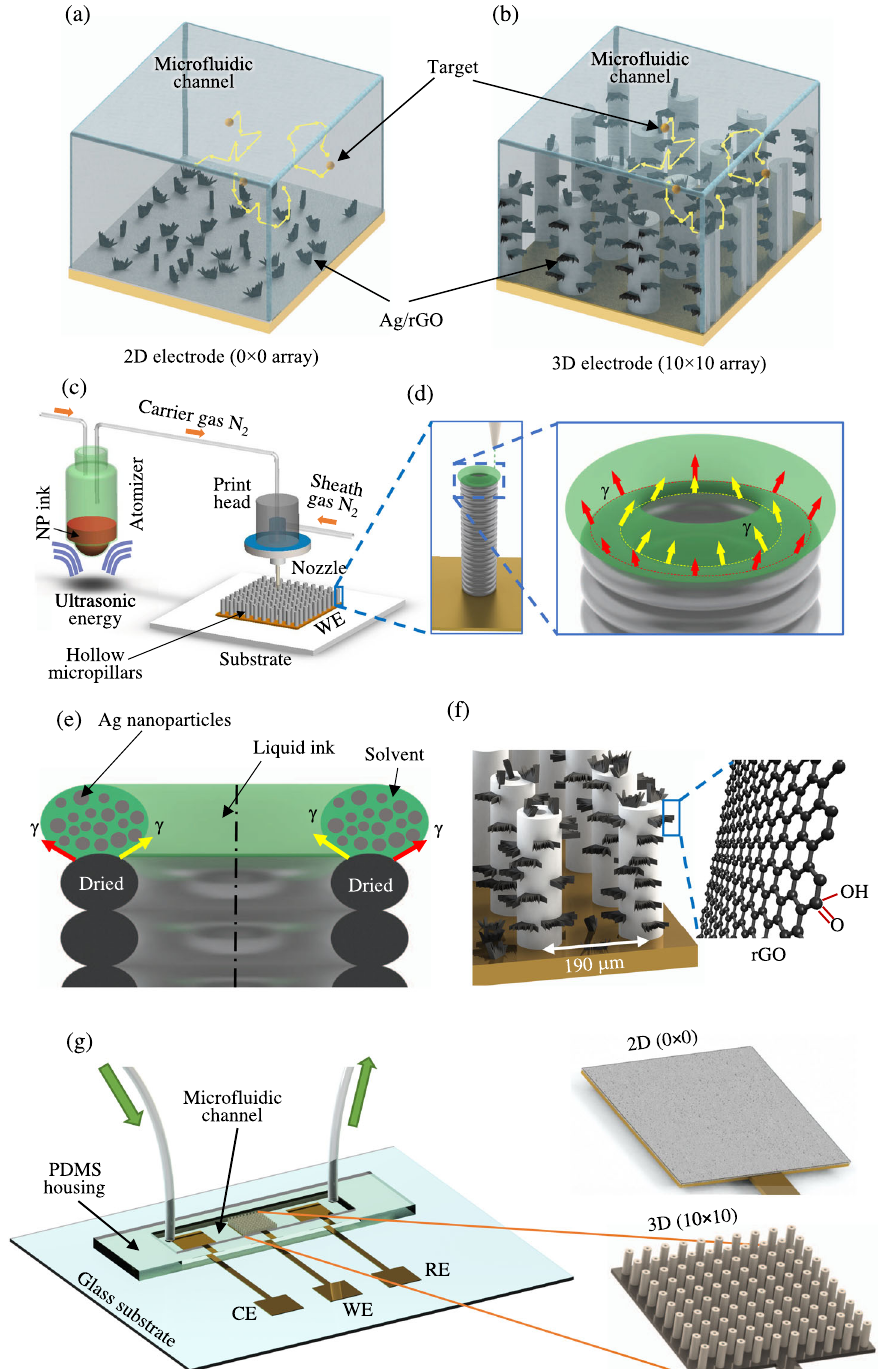
fraction of a second. The heating of the dried micropillar array removed the binders and sintered the nanoparticles to create the 3D electrode array. Note that the printing method shown in Fig. 1d, e uses aerosol droplet dynamics to form the 3D electrodes and does not depend on the chemistry of metal nanoparticles in the ink. As a result, the construction method for the 3D micro- pillars is applicable to other functional materials, as long as the corresponding nanoparticle inks are being used. Figure 1f shows the rGO fl akes that adhere to the silver micropillar electrodes. The exfoliated rGO sheets partially cover the micropillar